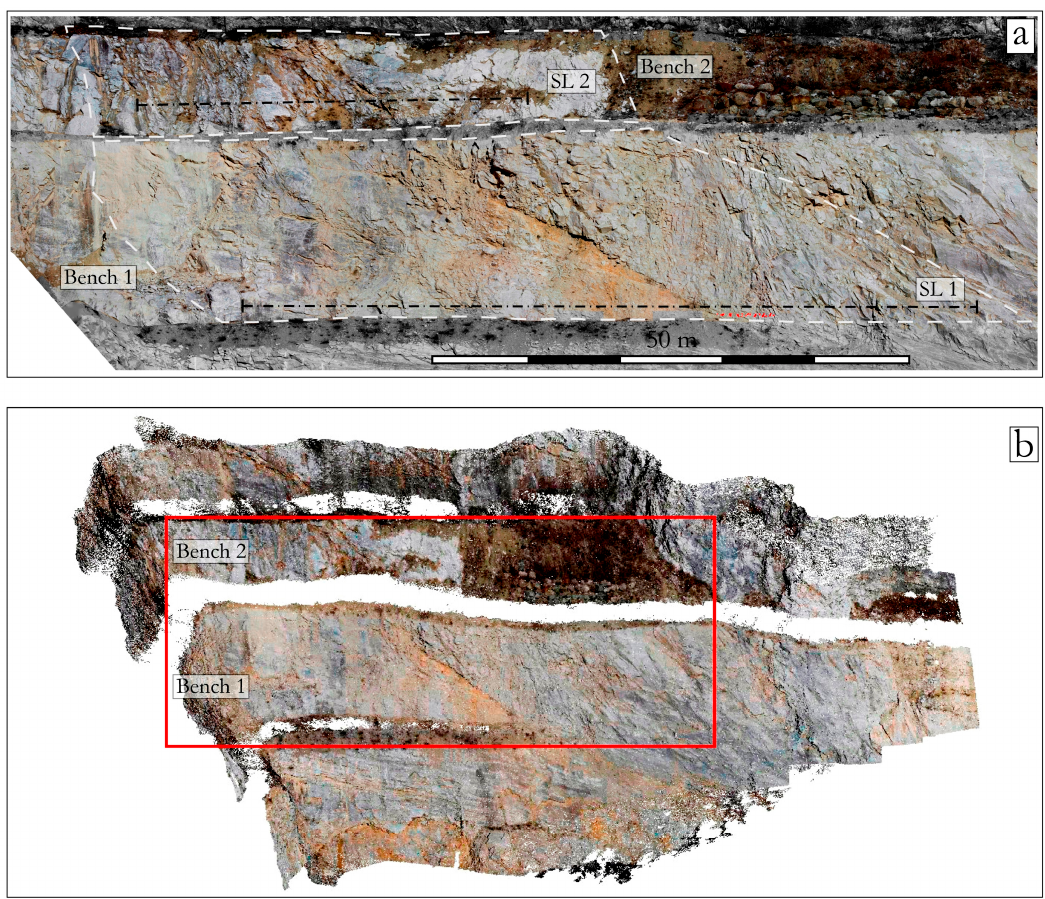
Figure 3. Details of the study area. ( a ): orthomosaic. ( b ): Image of the dense cloud reconstructed using MicMac software. In the red box is the surveyed area.